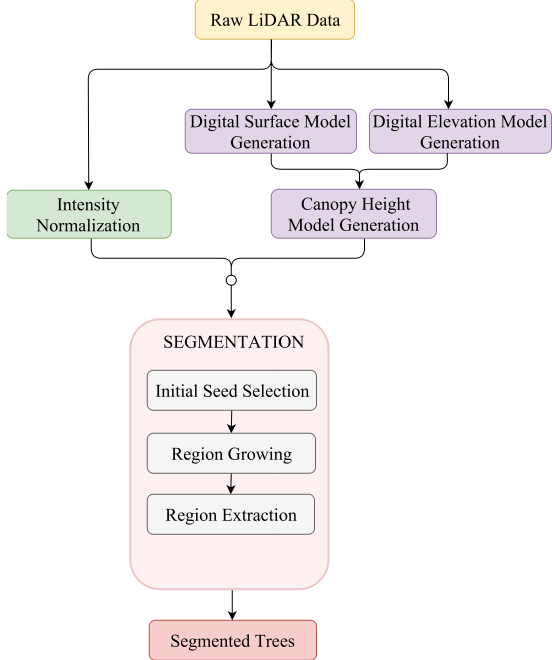
Figure 3. Proposed Methodology for ITC Delineation from Multi-Spectral LiDAR